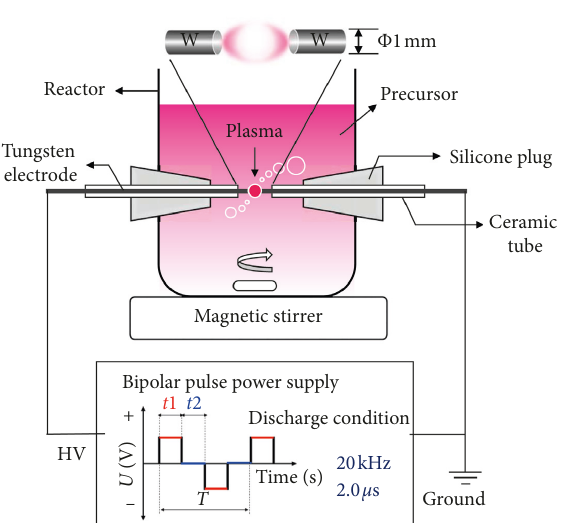
Figure 1: Schematic configuration of solution plasma (SP) reactor setup for synthesis of MnO 2